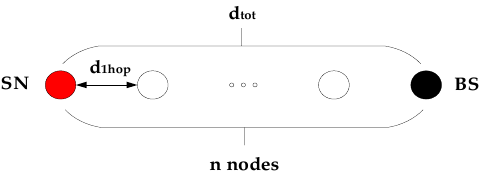
Figure 2. Node communication